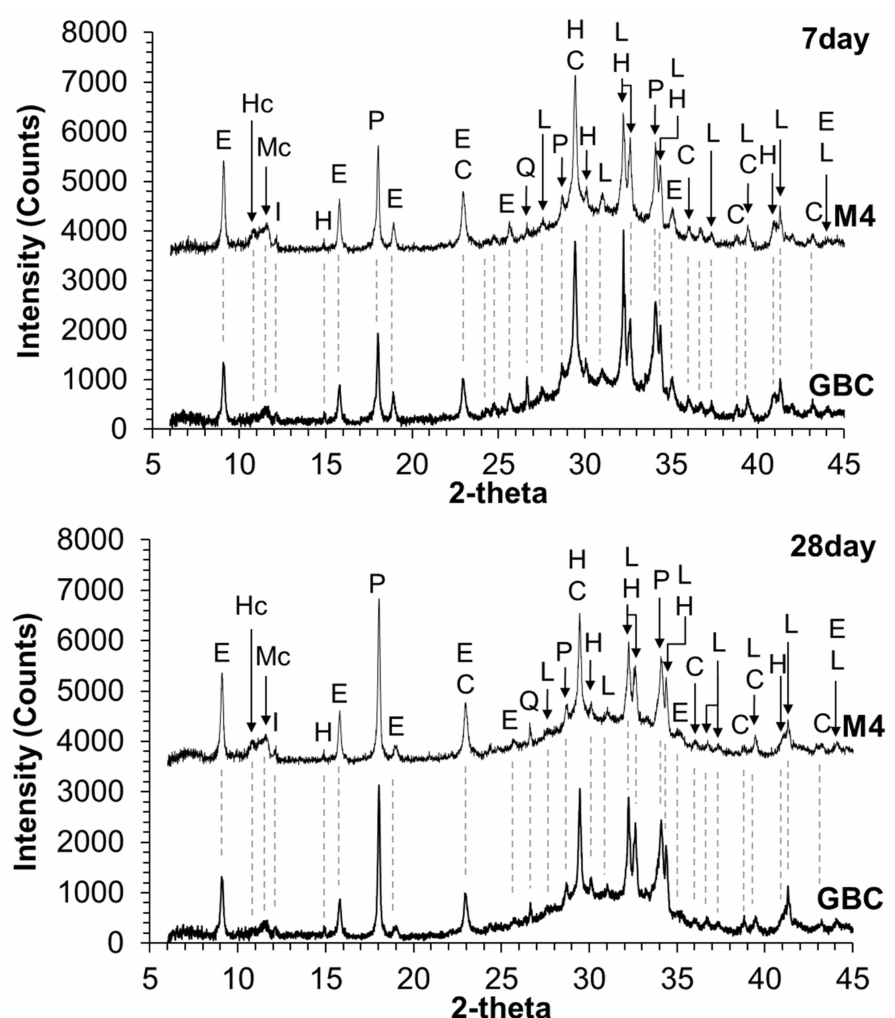
Figure 9. X-ray diffractograms of hydrated GBC and